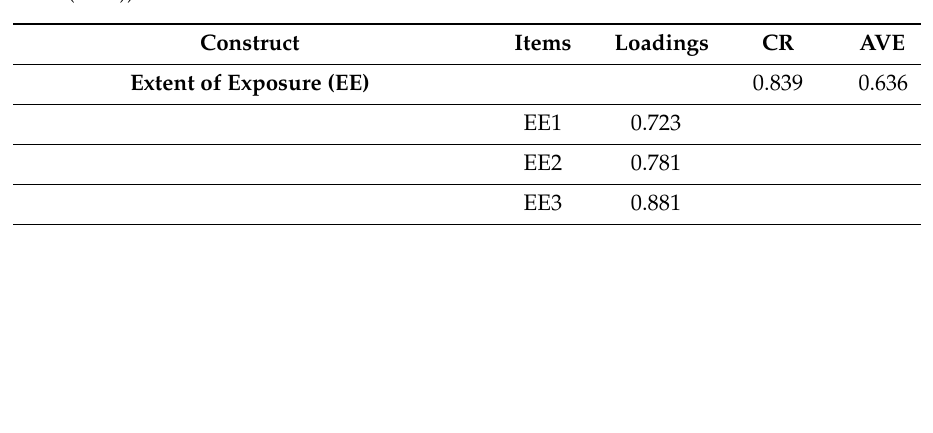
Table 1. Assessment results (Factor Loading, Composite Reliability (CR) and Average Variance Extracted